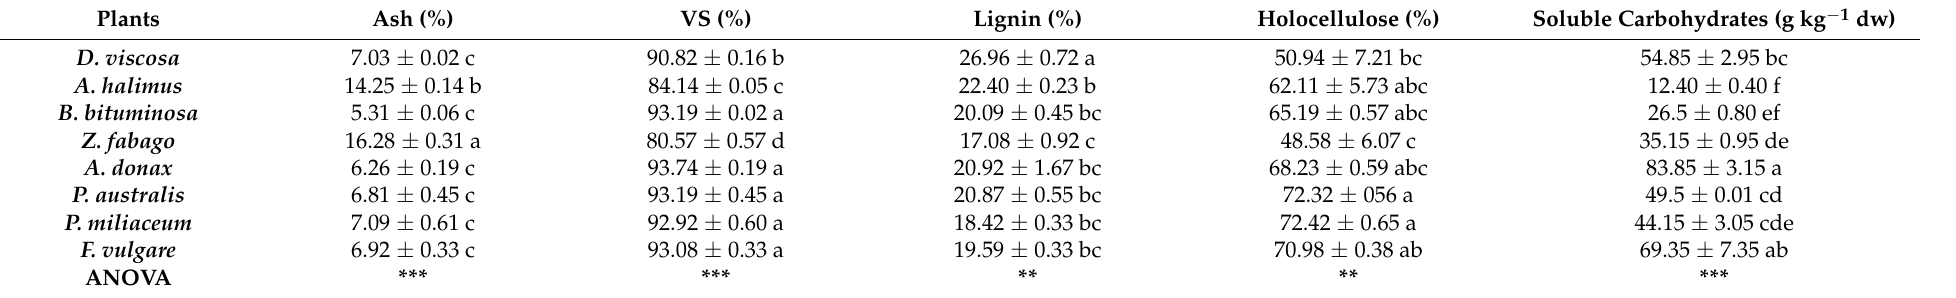
Table 2. Chemical composition of the plants used in the experiments (average values ± se, n = 2).